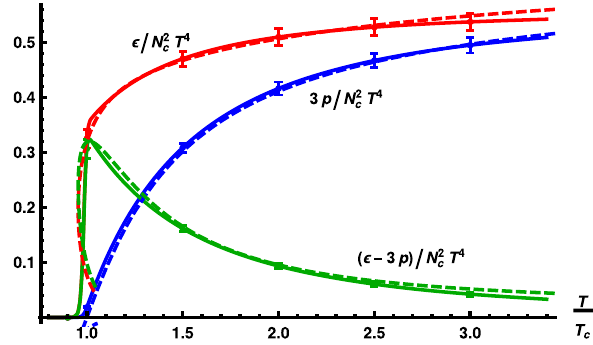
Fig. 6 Fitting V g (λ) to the large N c lattice data for pure Yang Mills. Red, blue, and green curves are for (normalized) energy density, pres- sure, and interaction measure ((cid:5) − 3 p )/ T 4 , respectively. Solid curves and error bars show the lattice data [283], and the dashed curves are our fit. Figure taken from